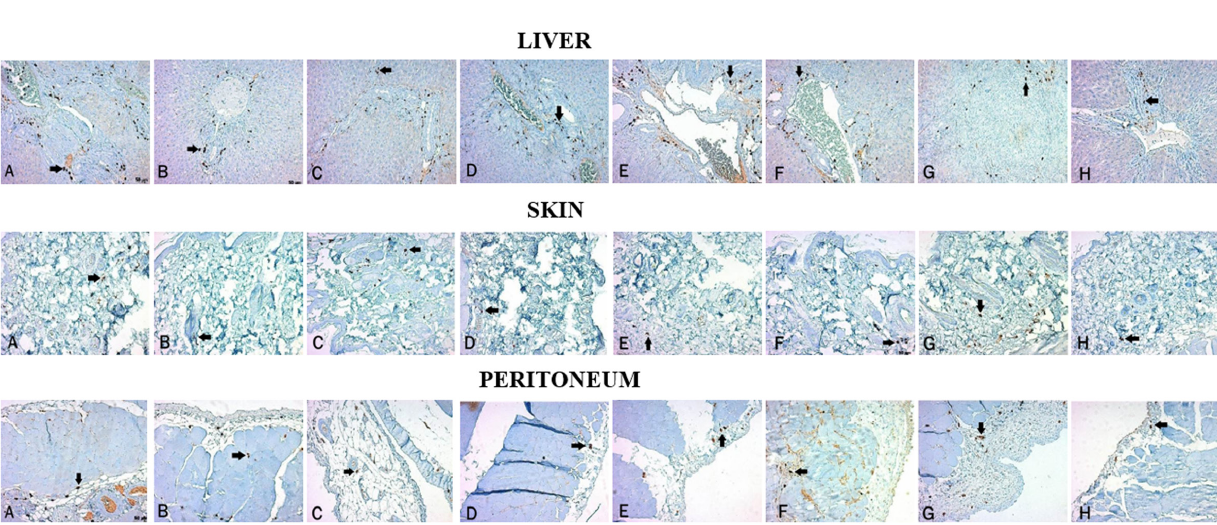
Figure 7. Mast cell distribution of the liver, skin, and peritoneum with immunohistochemical staining is demonstrated (mast cells are shown with arrows). (A) Control group, (B) sham group, (C) BDL+CPM group, (D) BDL+SERT group, (E) BDL+OND group, (F) BDL+UDCA group, (G) BDL+NAL group, and (H) BDL+CROM group. BDL, bile duct ligation; CROM, cromolyn sodium; CPM, chlorpheniramine maleate; SERT, sertraline; OND, ondansetron; UDCA, ursodeoxycholic acid; NAL,